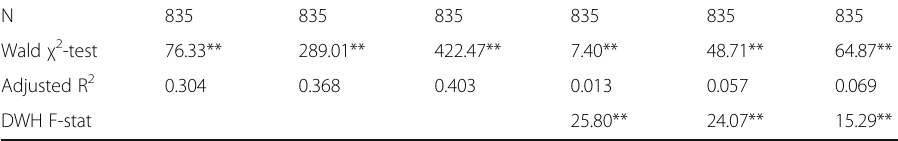
Table 4 Results of second stage regressions and robustness check a